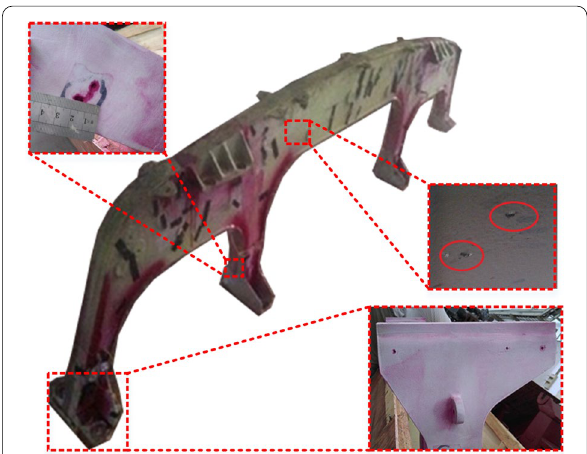
Figure 6 Liquid penetrant test on the cast aluminum